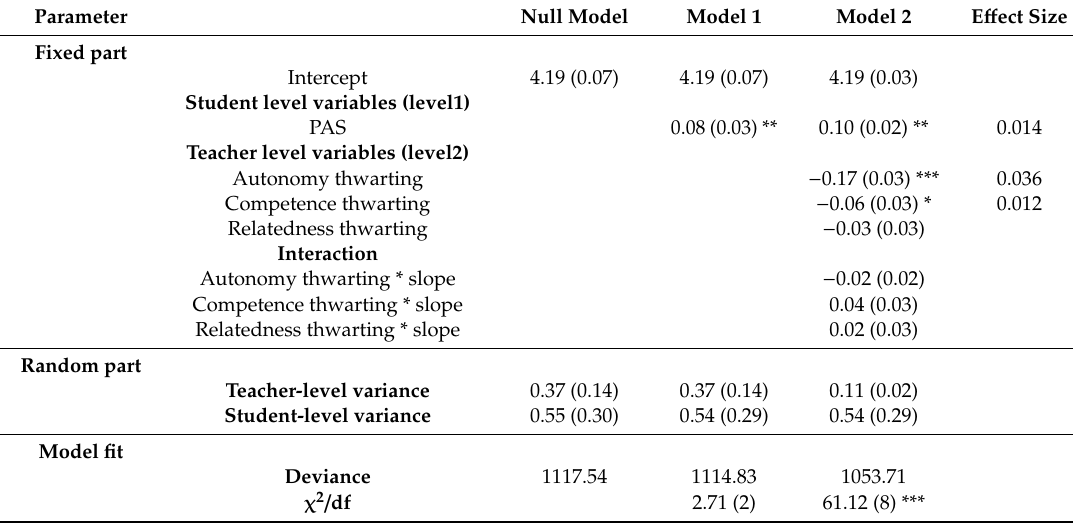
Table 3. Two-level multilevel analysis with behavioural engagement as a dependent variable and teachers’ need thwarting as a level-2